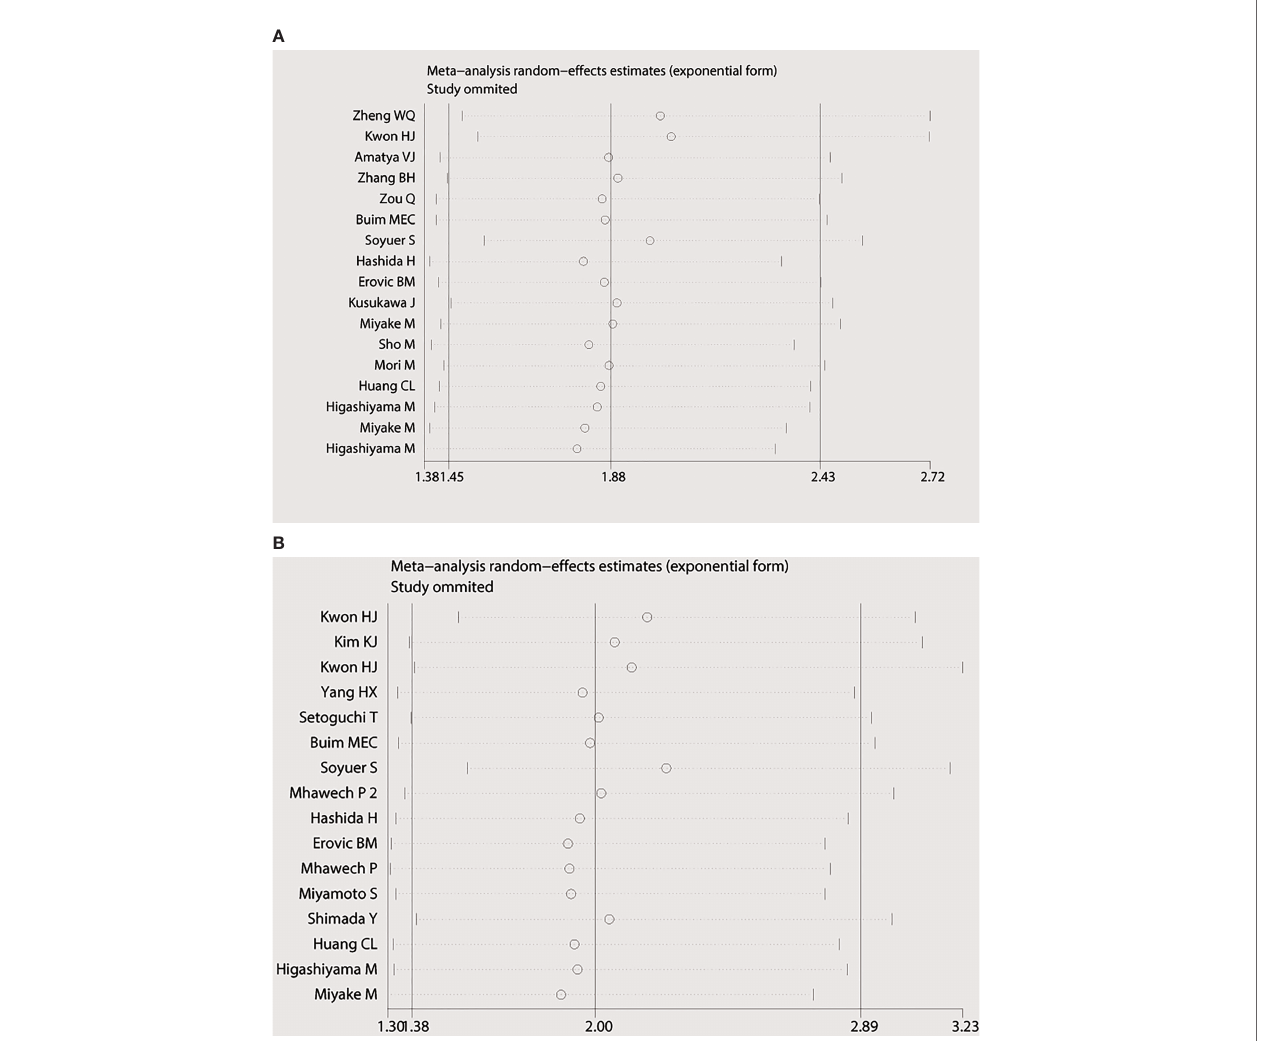
FIGURE 5 | Sensitivity analysis of the meta-analysis. (A) Overall survival. (B) Time to progression